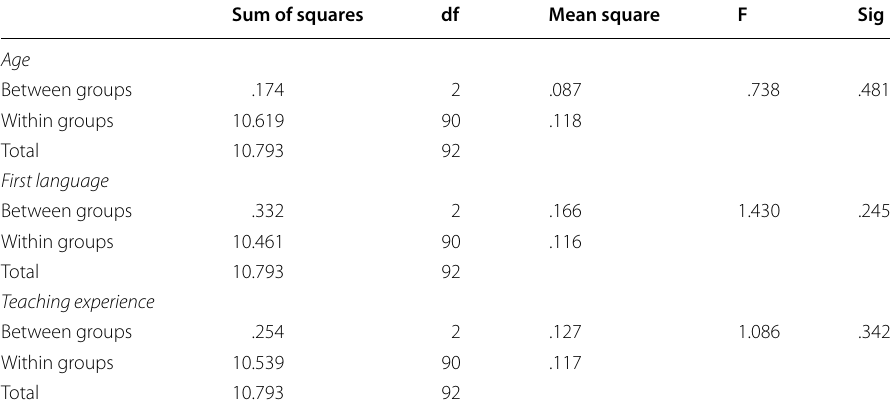
Table 8 ANOVA tests (age, first language, and teaching experiences) Sum of squares df Mean square Sig Age Between groups .174